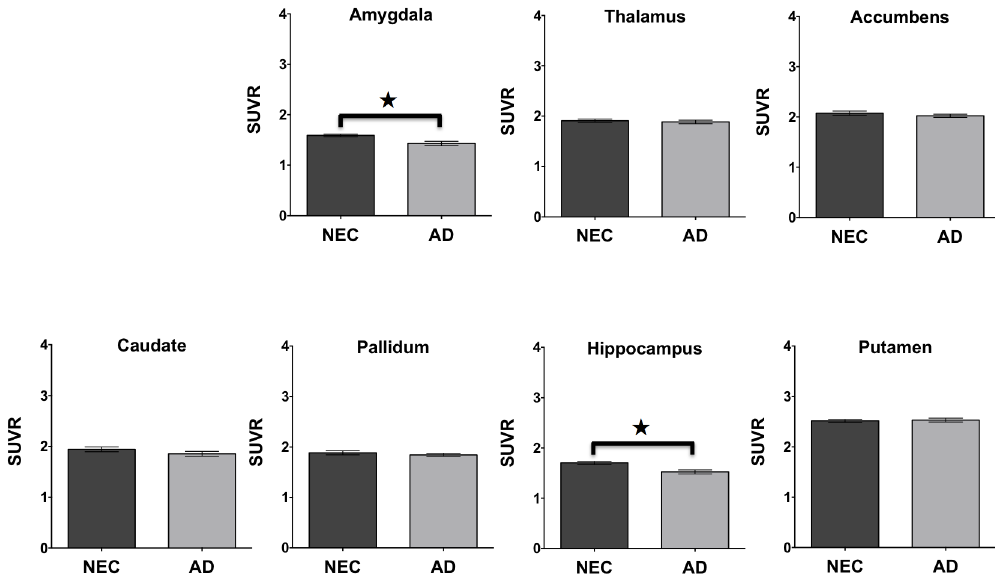
Fig 5. Regional glucose metabolism. The averageglucosemetabolismmeasured by FDG-PET SUVR in NEC and Alzheimer diseasesubjects in the amygdala,thalamus, accumbens, caudate, pallidum,hippocampus, and putamen. The error bars represent the standarderror of the mean and asterisks show significantdifferences betweengroups (adjusted p value, Bonferroni).